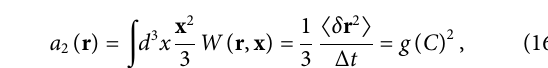
where W ( r , x ) is the probability per unit time that a walker jumps a distance x from r . Setting g ( C ) (cid:1) bC − c /2 gives z C (17)